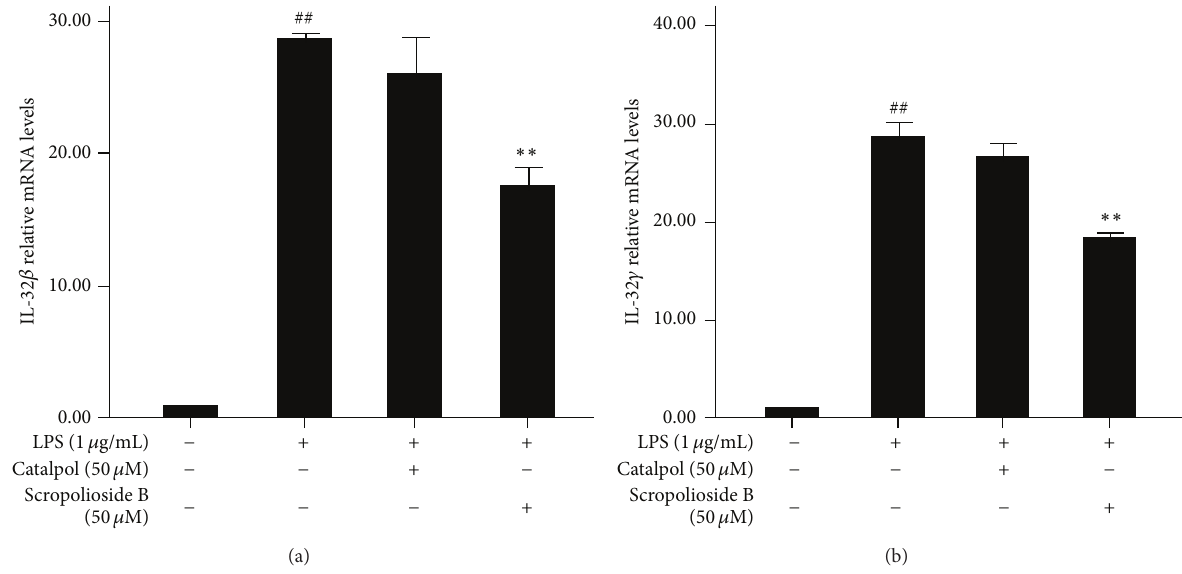
Figure 3: The effects of scropolioside B and catalpol on LPS-induced expression of IL-32 𝛽 and IL-32 𝛾 in THP-1 cells. THP-1 cells were pretreated with 50 𝜇 mol/L catalpol or scropolioside B for 1h and then stimulated with LPS (1 𝜇 g/mL) for another 24 h. The expression of IL- 32 𝛽 and IL-32 𝛾 mRNA was measured by RT-PCR. The data represent the mean values of over three experiments ± SD. ## 𝑃 < 0.01 compared to vehicle control, # 𝑃 < 0.05 compared to vehicle control, ∗∗ 𝑃 < 0.01 compared to LPS alone, and ∗ 𝑃 < 0.05 compared to LPS